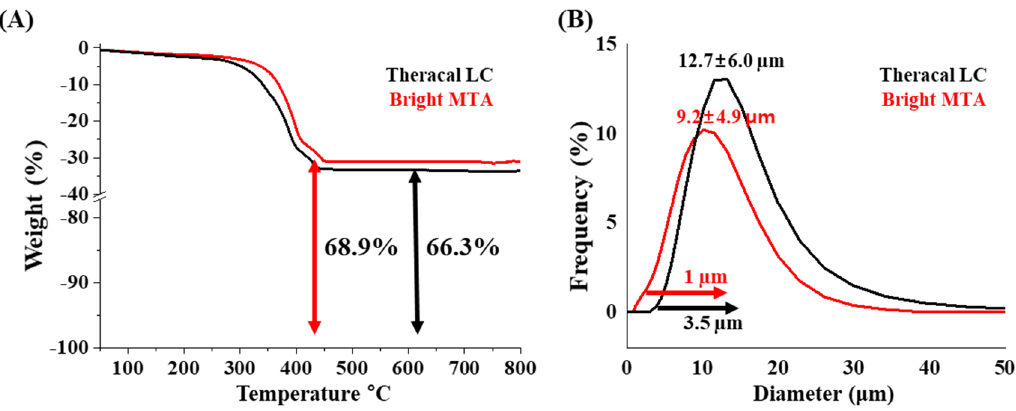
Figure 2. Inorganic amount and size distribution TheraCal LC and bright MTA. ( A ) Thermogravimetric analysis (TGA) results from 100 °C to 800 °C (n = 5) and ( B ) size distribution analysis after heat treatment at 800 °C (n = 5).